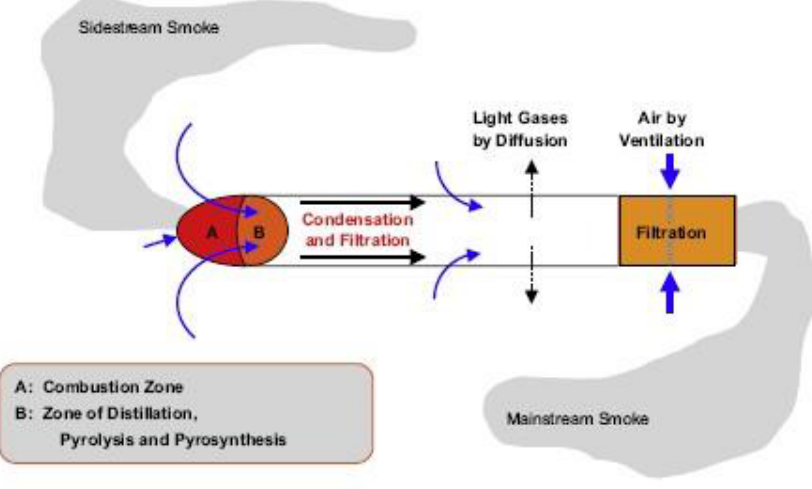
Figure 4. Main-Stream Smoke and Side-Stream Smoke in a burning cigarette (Thielen et al .